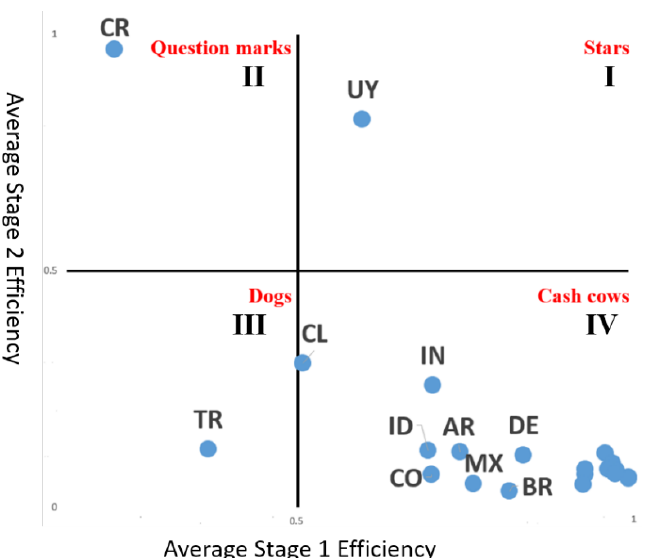
Figure 5. BCG matrix reference.